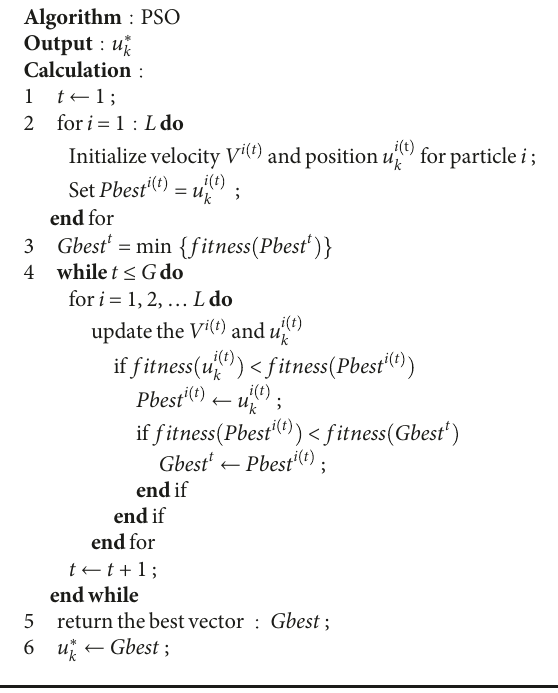
Algorithm 2: Pseudocode of solving optimal control